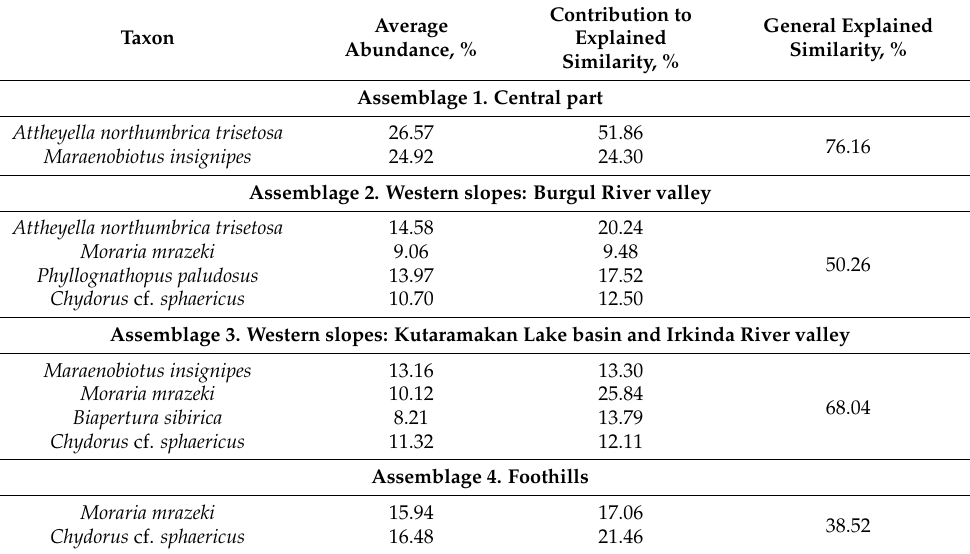
Table 5. Characteristic species of meiobenthic crustacean assemblages from waterbodies of different districts of the Putorana Plateau.